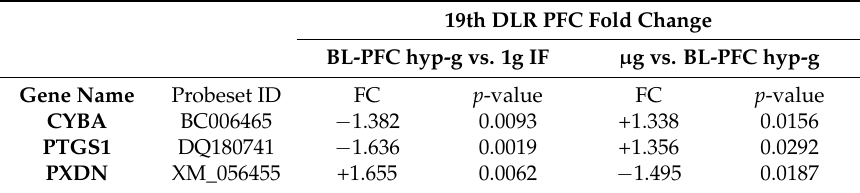
Table 6. Differentially regulated transcripts identified for the parabolic flight data sets. All of the transcripts were reversely regulated with respect to microgravity and hypergravity conditions. Plus: significantly up-regulated transcripts ( p -value < 0.05, fold change (FC) ≥ +1.3); minus: significantly down-regulated transcripts ( p -value < 0.05, FC ≤ − 1.3). FCs are ratios between the averages of the linear expression values. If the ratio is <1, FC is calculated as the negative reciprocal of the ratio. For the abbreviations of the experiment group names see Table 1.